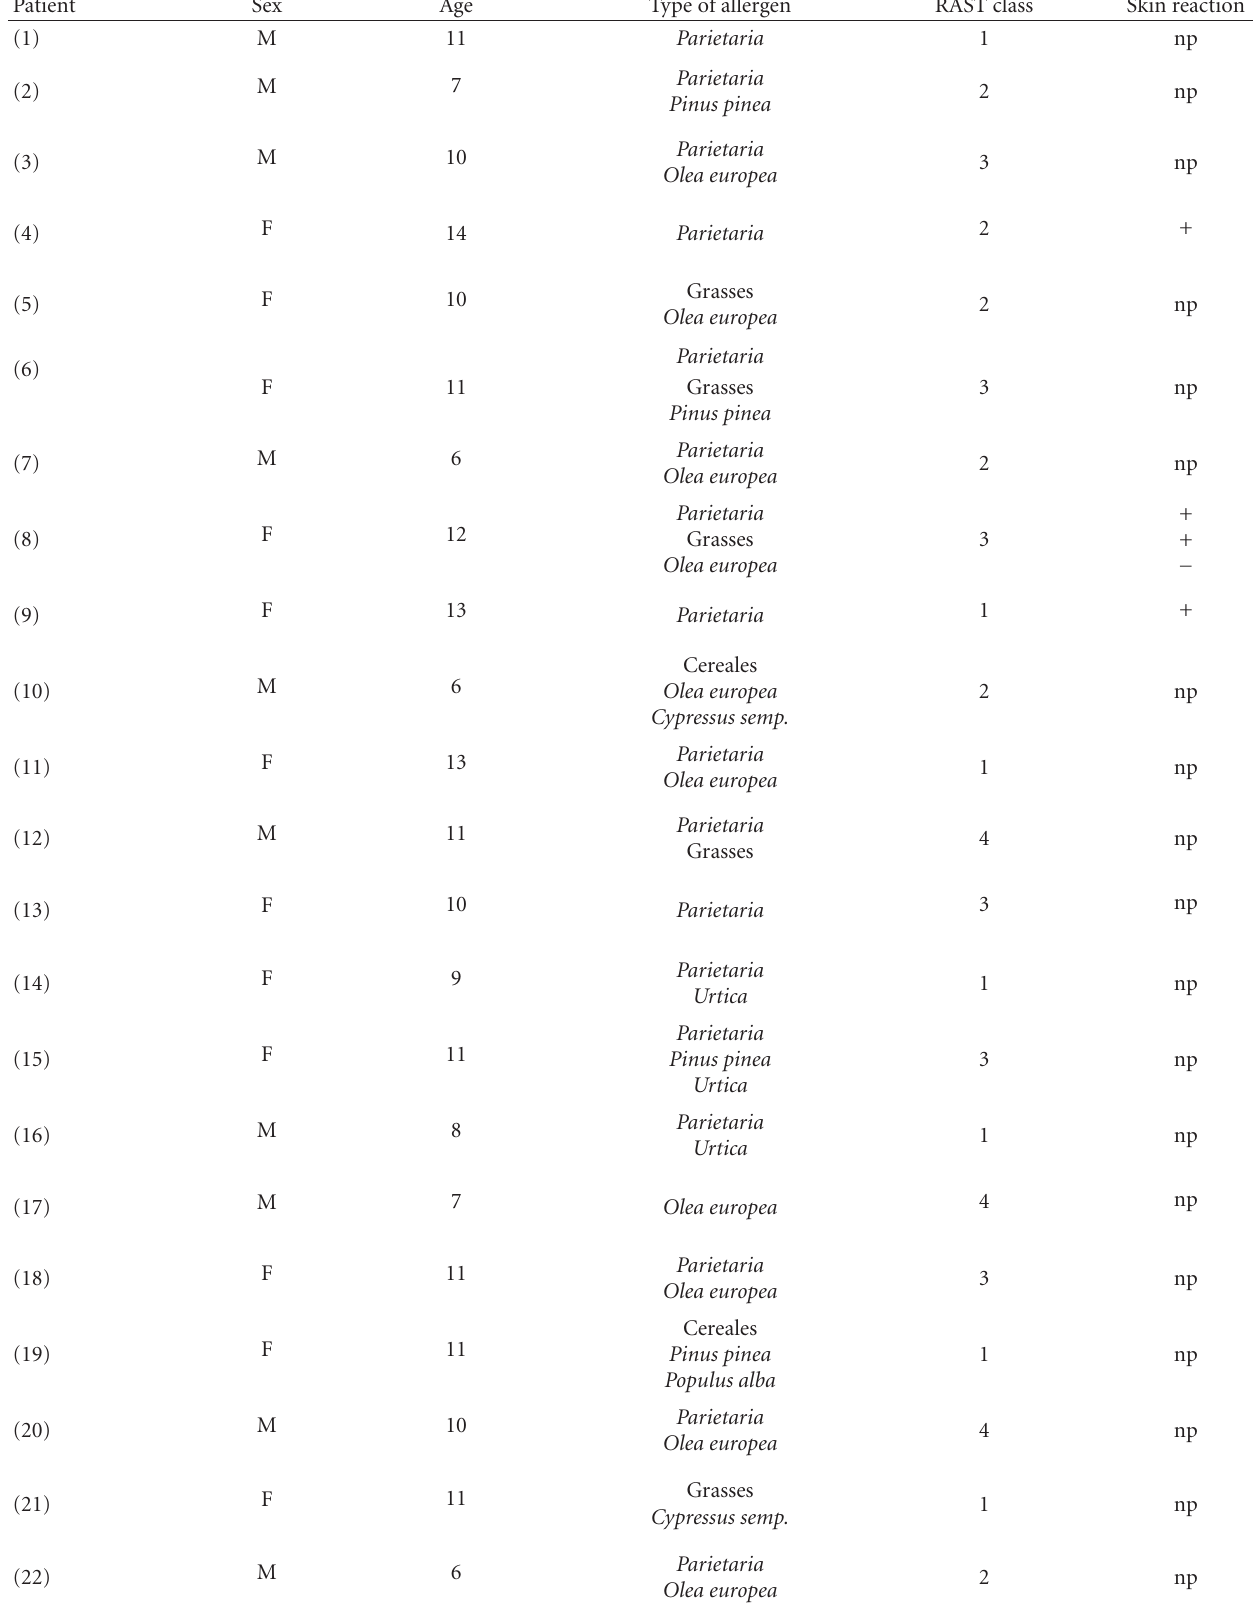
Table 2: Types of allergens, RAST classes, and skin